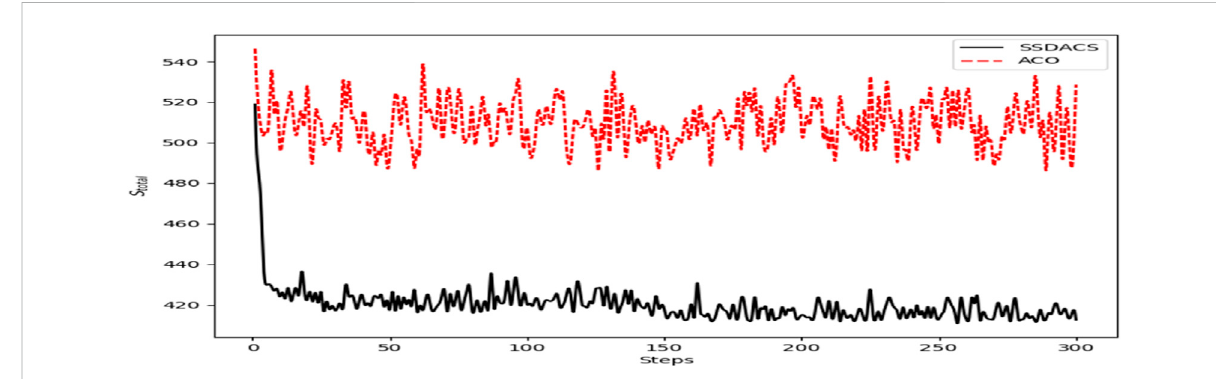
FIGURE 12 The comparison of the re fl ection of positive feedback mechanism ( S total ) between DSSACS and